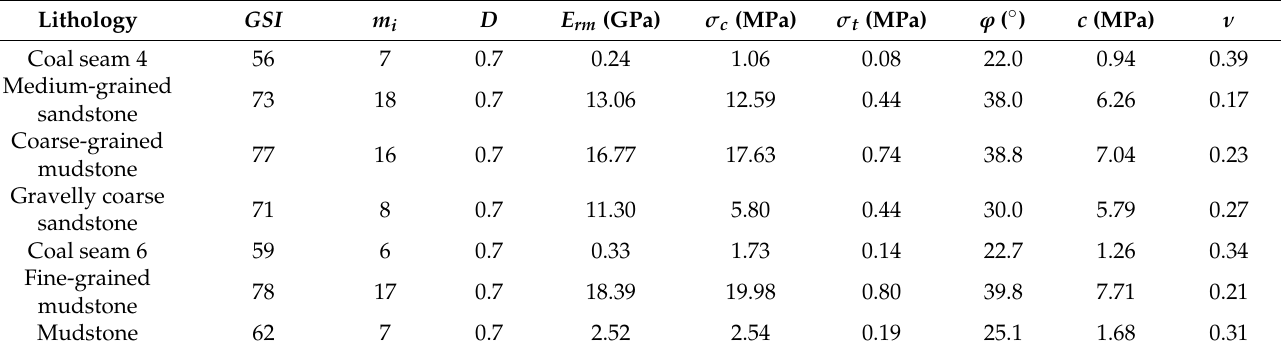
Table 2. Revised properties of rock mass by Hoek–Brown strength